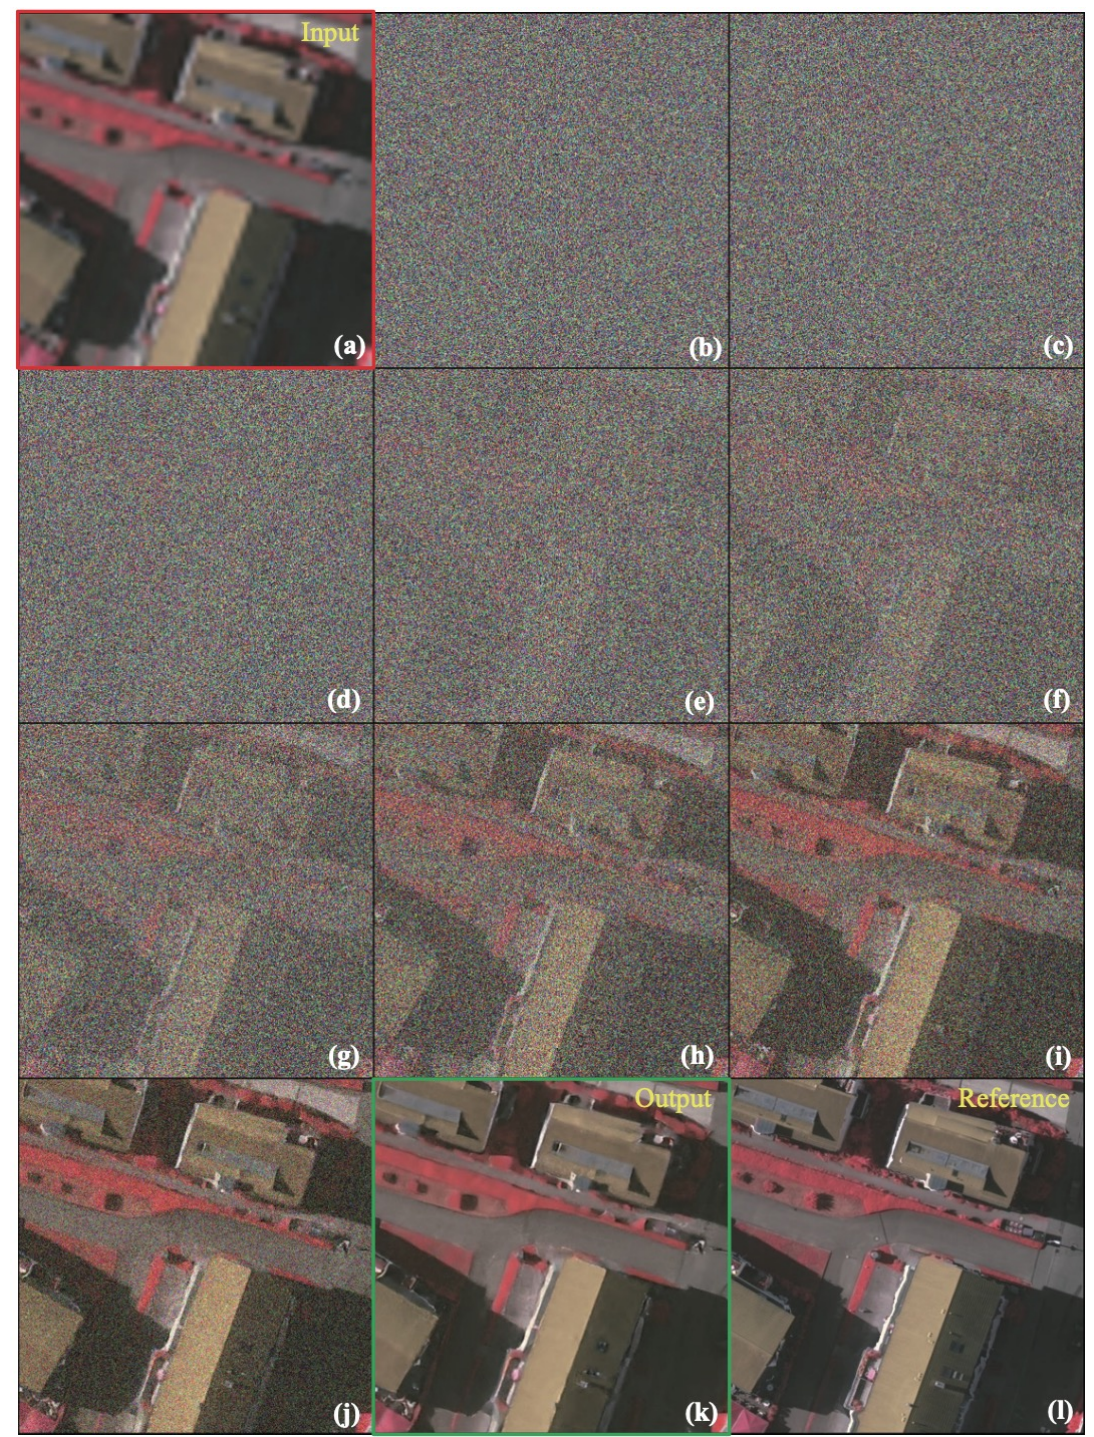
Figure 6. On ISPRS-Vaihingen test dataset, 64 × 64 input resolution to visually compare the image reconstruction results. The test was transferred directly without any fine-tuning. ( a : input) the input image. ( b – j ) the results of the image reconstruction process. ( k : output) image reconstruction results. ( l : reference) tag. Zoom-in for better